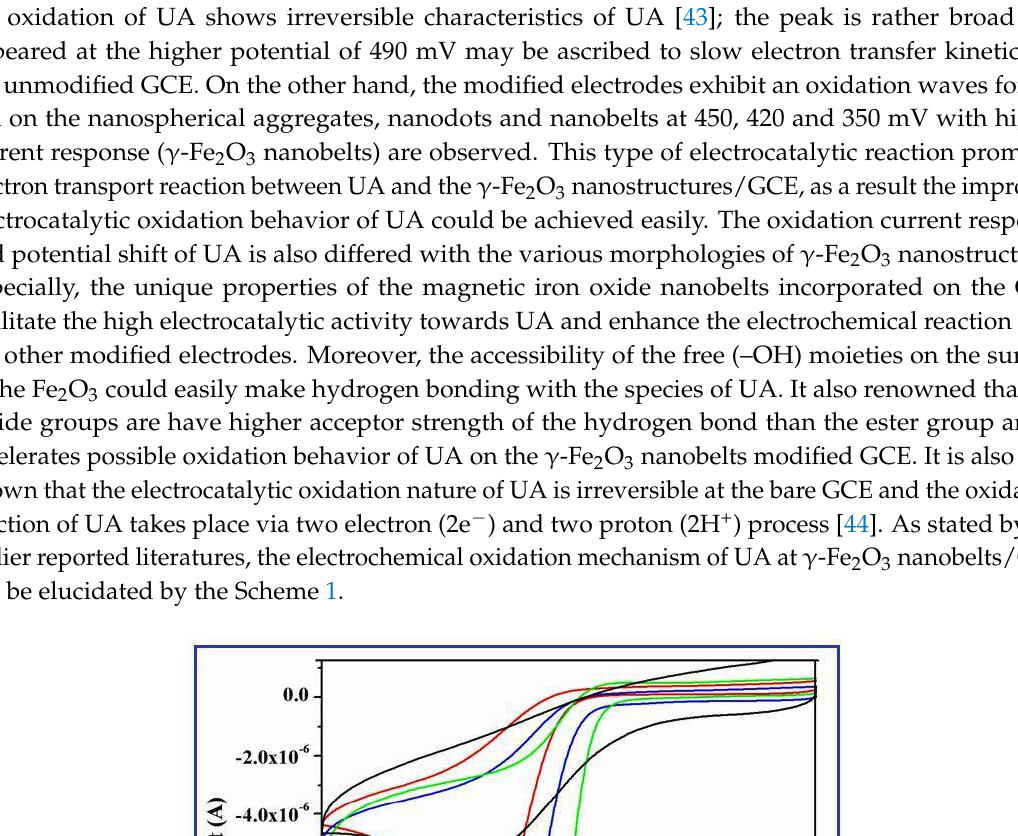
Figure 7. Cyclic voltammetric responses of ( a ) unmodified GCE, ( b ) γ-Fe 2 O 3 nanoparticle aggregates/GCE ( c ) γ-Fe 2 O 3 nanodots/GCE and ( d ) γ-Fe 2 O 3 nanobelts/GCE at 0.3 mM UA dissolved in 0.1 M PBS (pH 7.4) solution recorded at a scan rate of 50 mV/s.